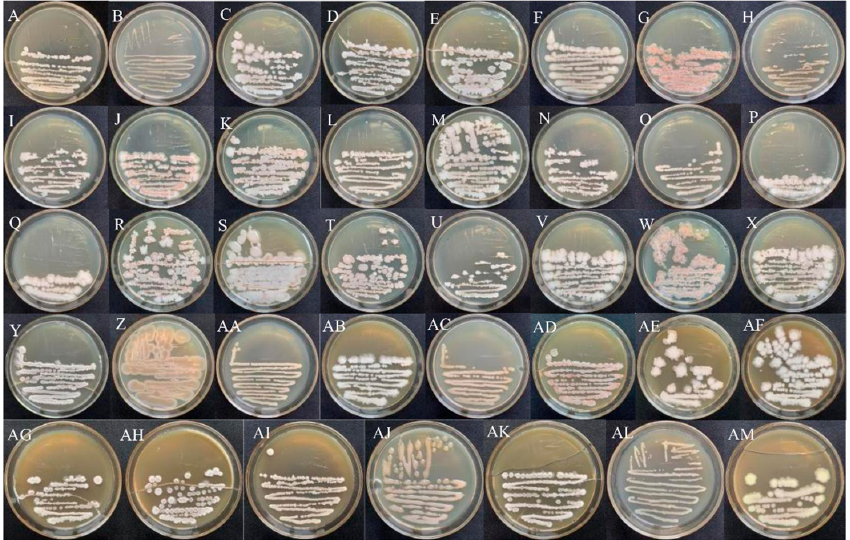
Figure 1. Morphological characteristics of 39 endophytic bacteria. ( A ): b1, ( B ): b2, ( C ): b3, ( D ): b4,